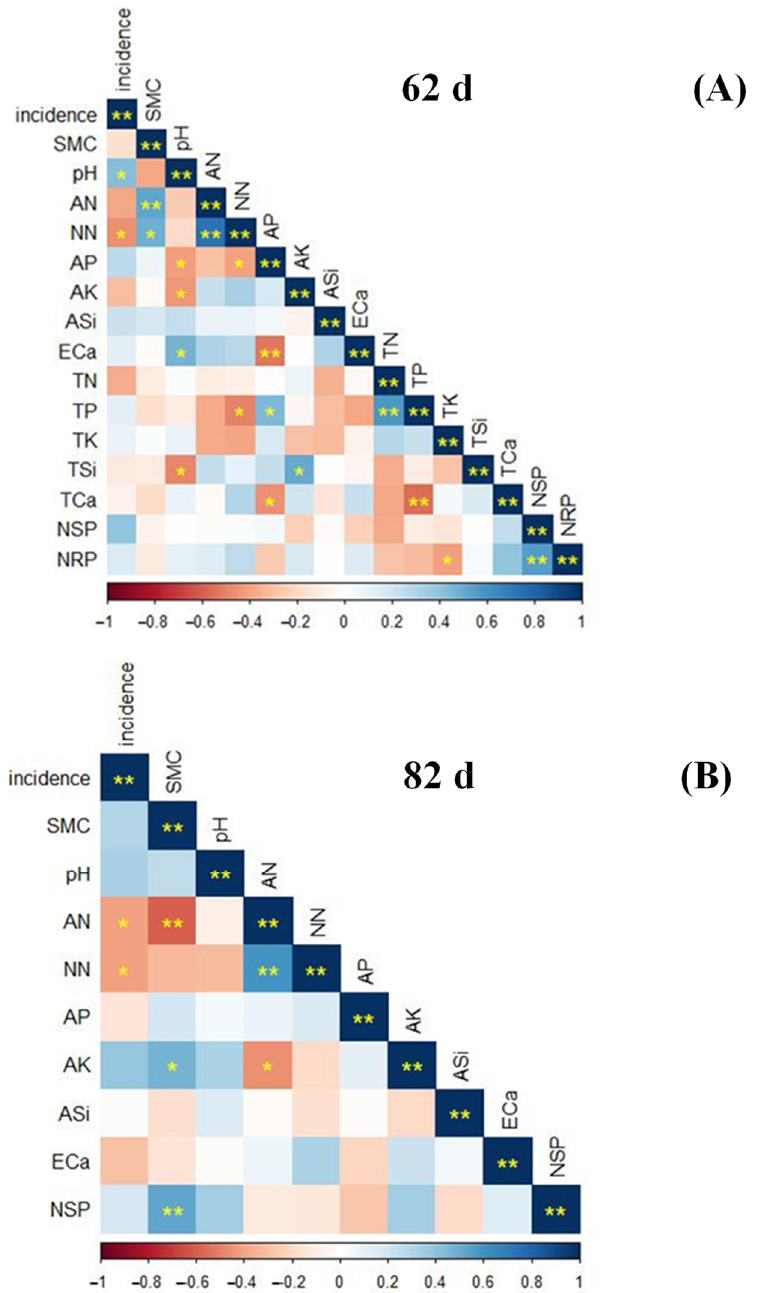
Figure 3. Spearman correlation analysis of the physicochemical properties [SMC (soil moisture content), AN (ammonia nitrogen), NN (nitrate nitrogen), AP (available phosphorus), AK (available potassium), ASi (available silicon), ECa (effective calcium), TN (total nitrogen), TP (total phosphorus), TK (total potassium), TSi (total silicon), TCa (total calcium), NSP (number of soil pathogens), NRP (number of root pathogens)] morbidity and number of pathogenic bacteria of different treatments at 62 d ( A ) and 82 d ( B ) after transplanting. p * < 0.05, p ** <0.01.